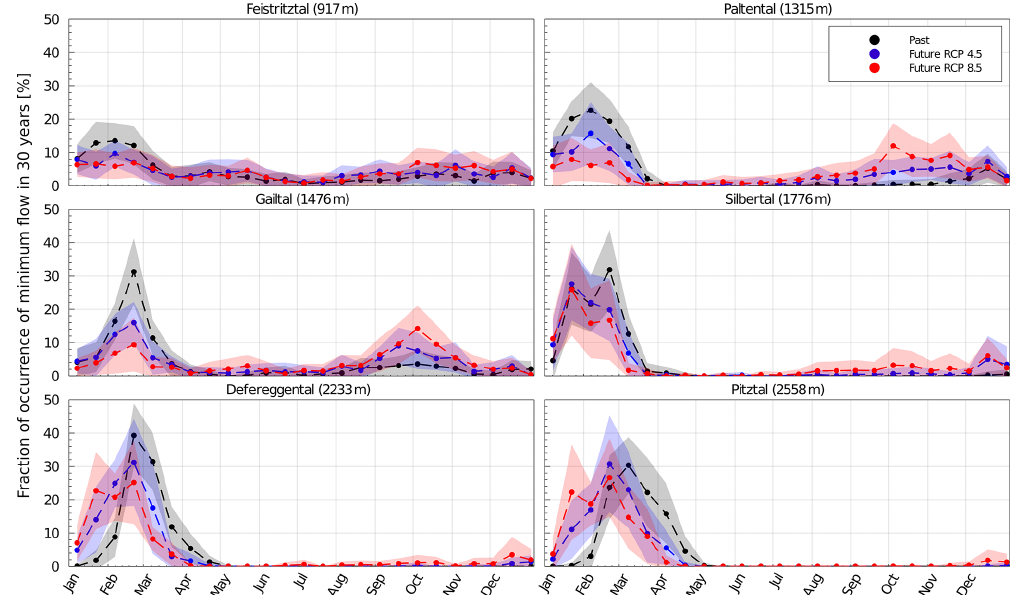
Figure 13. Mean fraction of occurrences of lowest annual 7d flow in the past (black dots) and future (blue dots – RCP4.5; red dots – RCP8.5) 30-year time periods, using time windows of 15d across all model simulations. The shaded areas indicate the associated ± 1SD. Dashed lines between the individual 15d periods are used for better visualization.